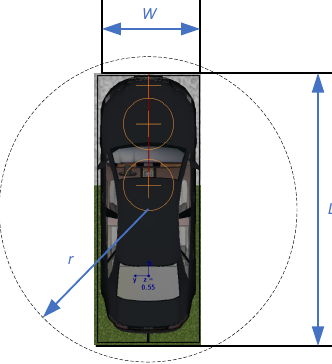
Figure 3. Circular model of vehicle body.